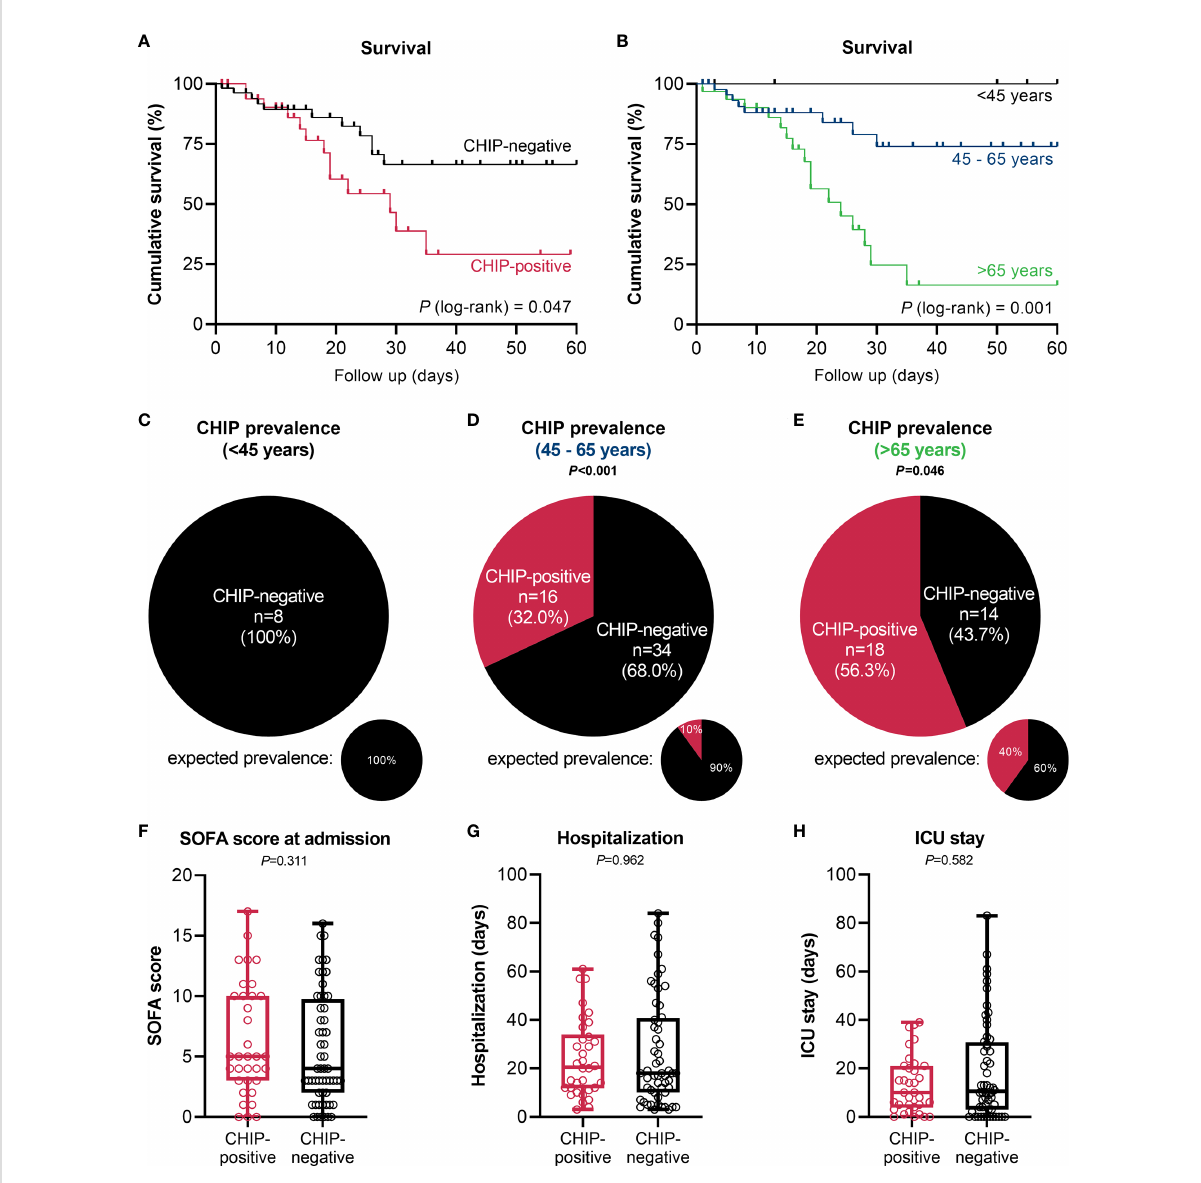
FIGURE 2 Impact of clonal hematopoiesis on patient outcome. (A) Kaplan-Meier survival curve for overall survival of CHIP-positive (n=34) vs. CHIP- negative (n=56) patients within a 60-day period. (B) Kaplan-Meier survival curve for overall survival of patients <45 years (n=8), 45 – 65 years (n=50), and >65 years (n=32) within a 60-day follow-up period. Statistical evaluations were done using log-rank Mantel-Cox test. CHIP prevalence in patients (C) <45 years, (D) 45 – 65 years, and (E) >65 years. Expected prevalences according to Watson et al. (4). Observed and expected prevalence were compared using binomial test. (F) SOFA score at admission, and length of (G) hospitalization and (H) ICU stay. Each data point represents an individual patient (CHIP-positive n=34; CHIP-negative n=56). Horizontal line within the box marks the median, boxes depict the IQR, and whiskers indicate the total range. Group comparisons were performed by two sided Mann – Whitney U-test. Statistically signi fi cant results (P ≤ 0.05) are highlighted by bold